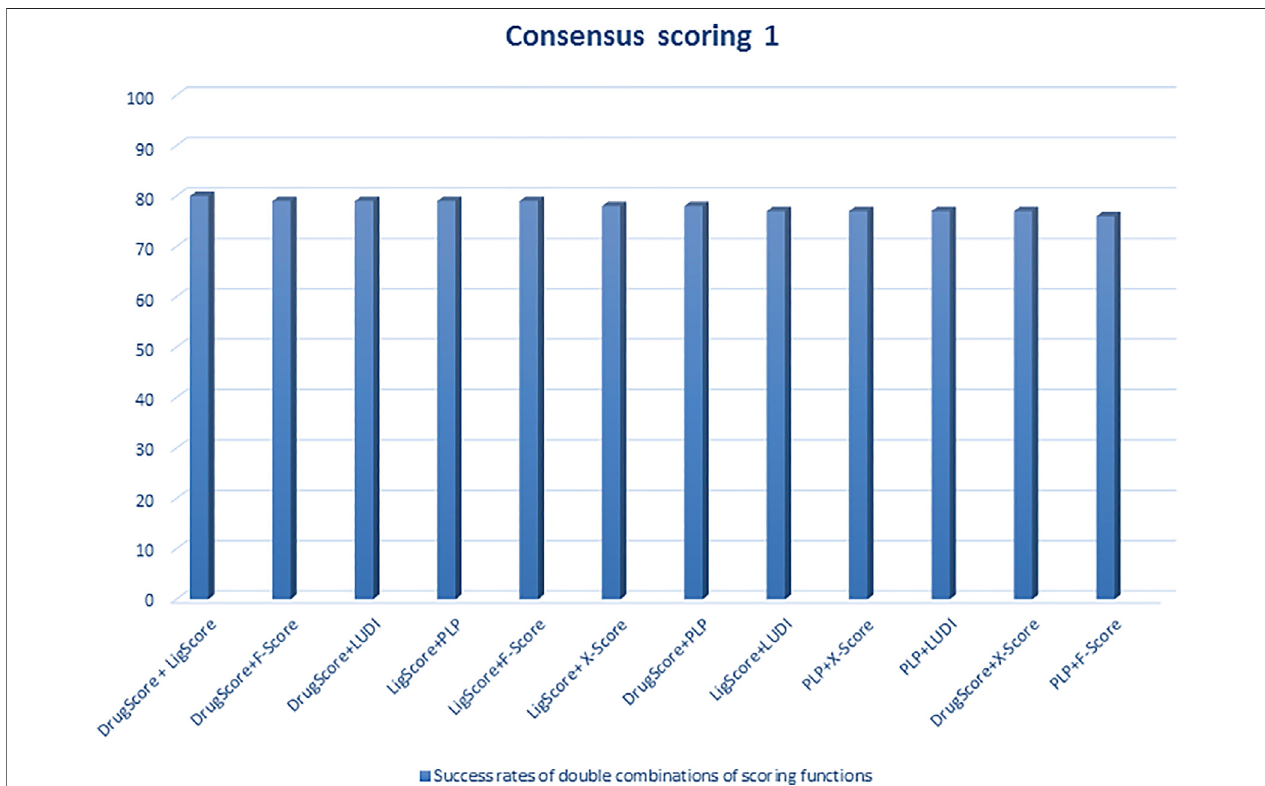
FIGURE 1 | Success rates of double combinations of the six relatively successful scoring functions in consensus scoring. All numbers are in percent (Wang et al., 2003).